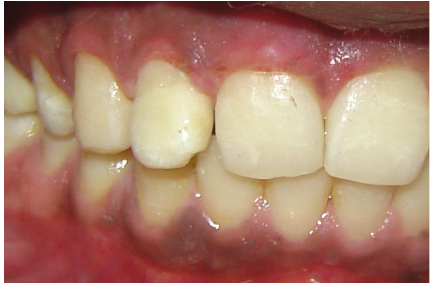
Figure 9: Labial view after two and half years.